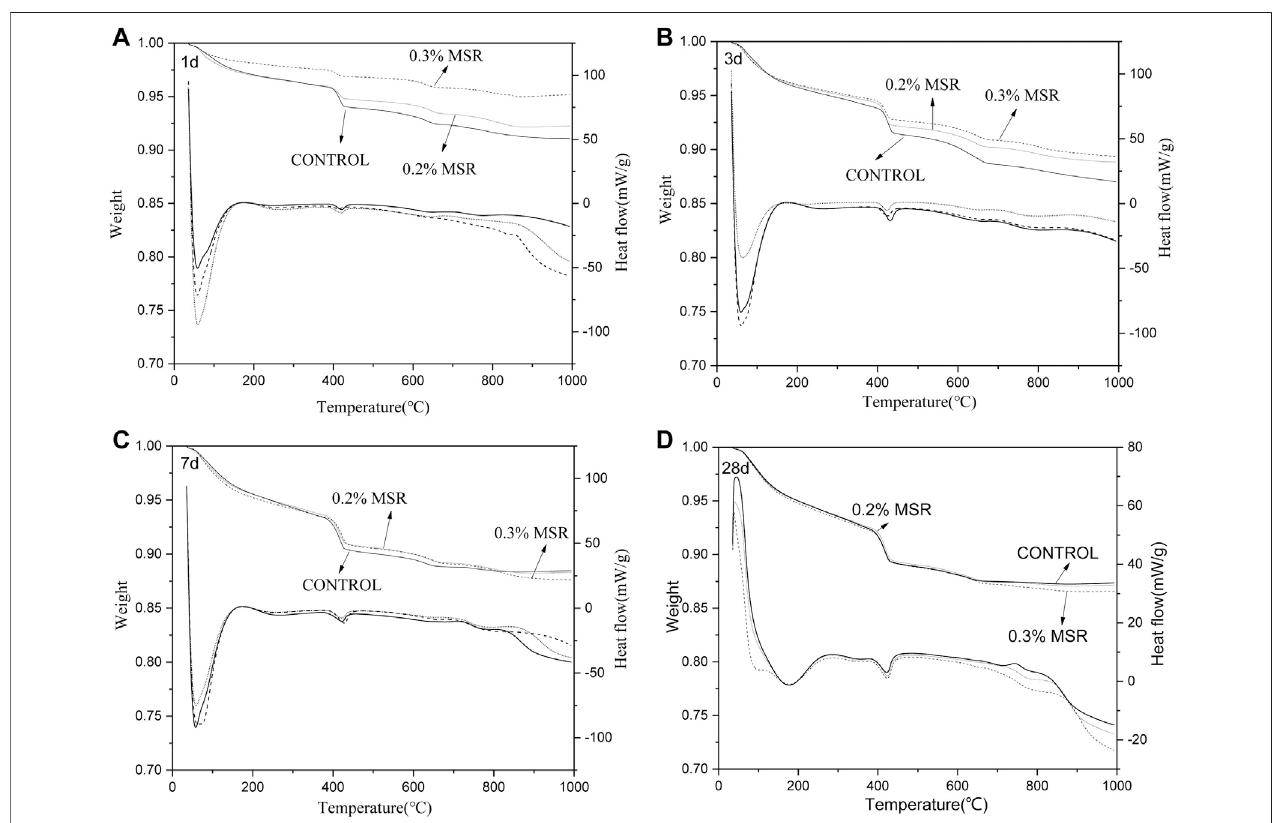
FIGURE 12 | TG-DSC curves of cement with MSR: (A) 1 day; (B) 3 days; (C) 7 days.